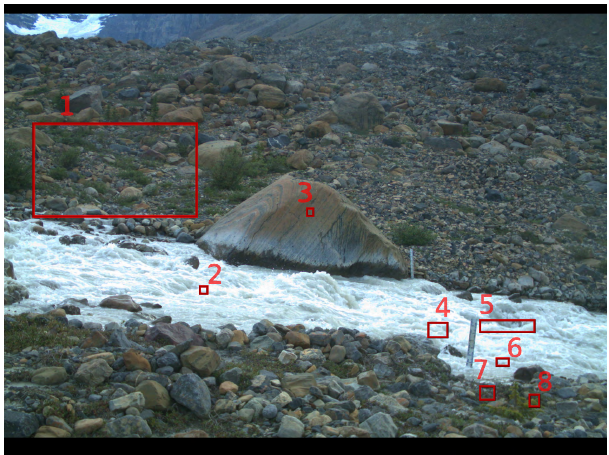
Figure 5. The eight different targets zones used in the picture clas- sification process.